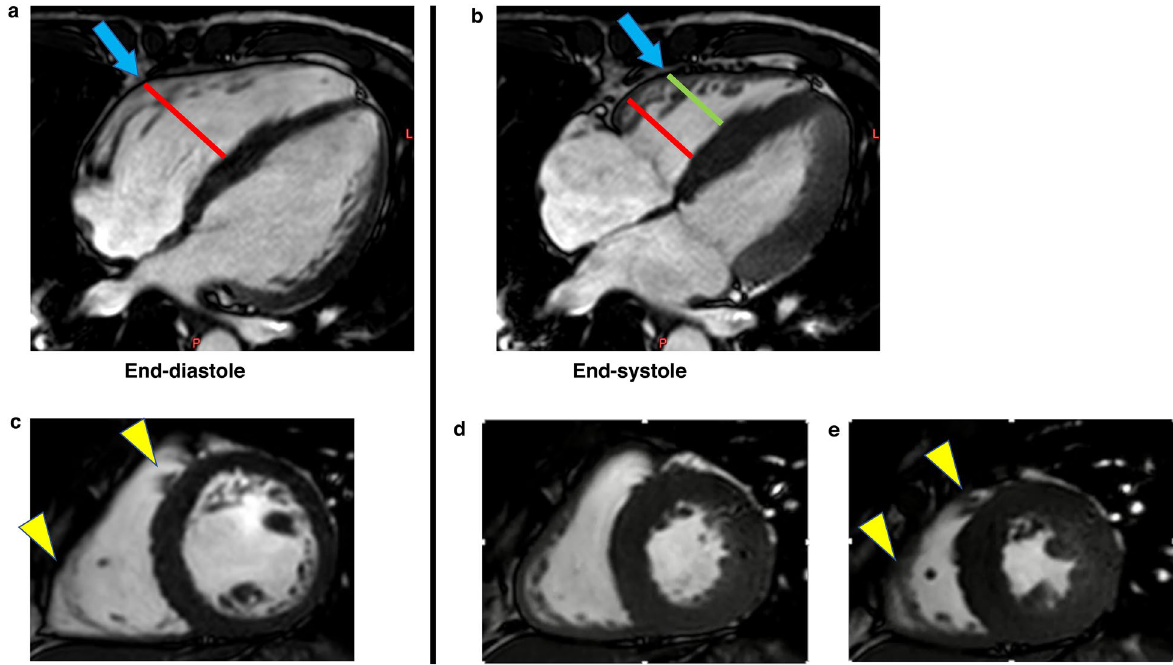
Figure 1. RV migration in the fixed LV short axis slice. Cine CMR of a subject with no structural abnormalities in the RV. In the four-chamber views, the RV portion marked by the blue arrows migrates in the cardiac cycle ( a , b ). ( c ) The LV short axis view along the red reference line in diastole. ( d ) The LV short axis view along the red reference line in systole. Circumferential strain was assessed between ( c , d ) on the same red reference line, regardless of the RV longitudinal shortening. ( e ) The LV short axis view along the green reference line in systole. Between ( c ) and ( e ), more significant circumferential shortening (than that seen in ( d )) and the same structure of the RV (yellow visual cues) are visible. RV Right ventricle, LV Left ventricle, CMR Cardiac magnetic